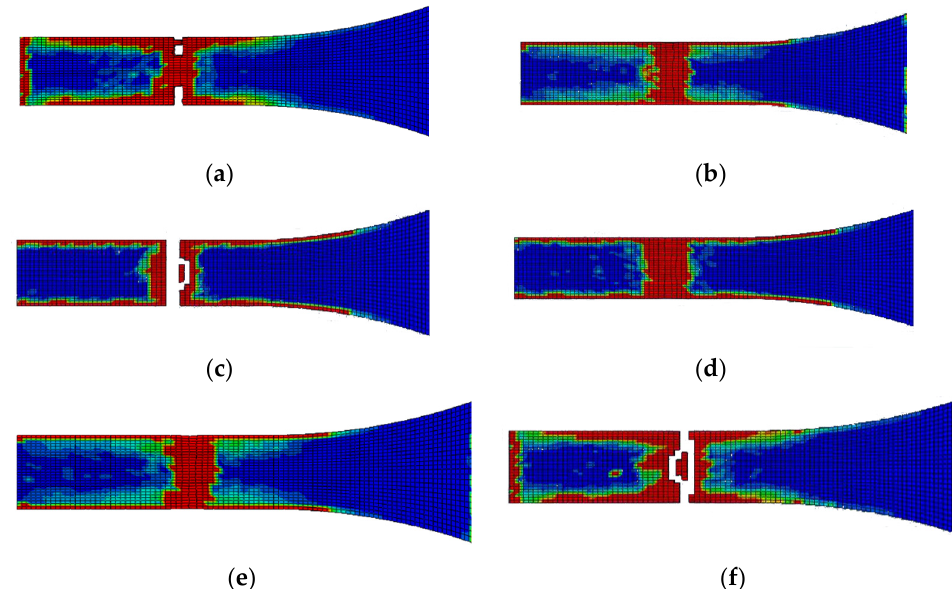
Figure 13. Delamination of each layer of laminate B after failure; ( a ) 1st interface; ( b ) 2nd interface;